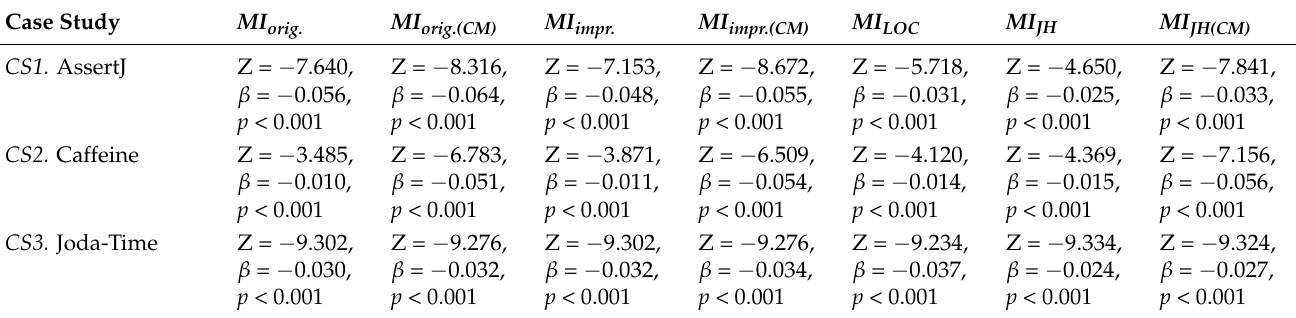
Figure 8. Visualizing similarities and dissimilarities after multidimensional scaling based on Kendall’s τ -b Correlation Coefficient. Table 13. Mann–Kendall Trend